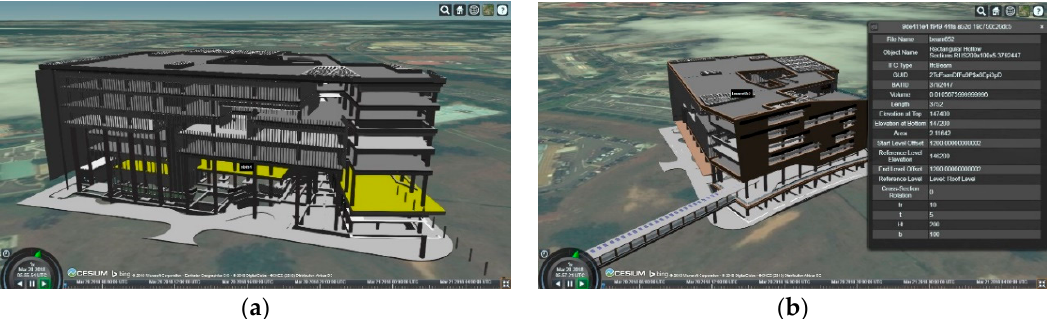
Figure 4. ( a ) Highlighted individual IFC component in the converted 3D Tiles; ( b ) query properties for each component from 3D Tiles.